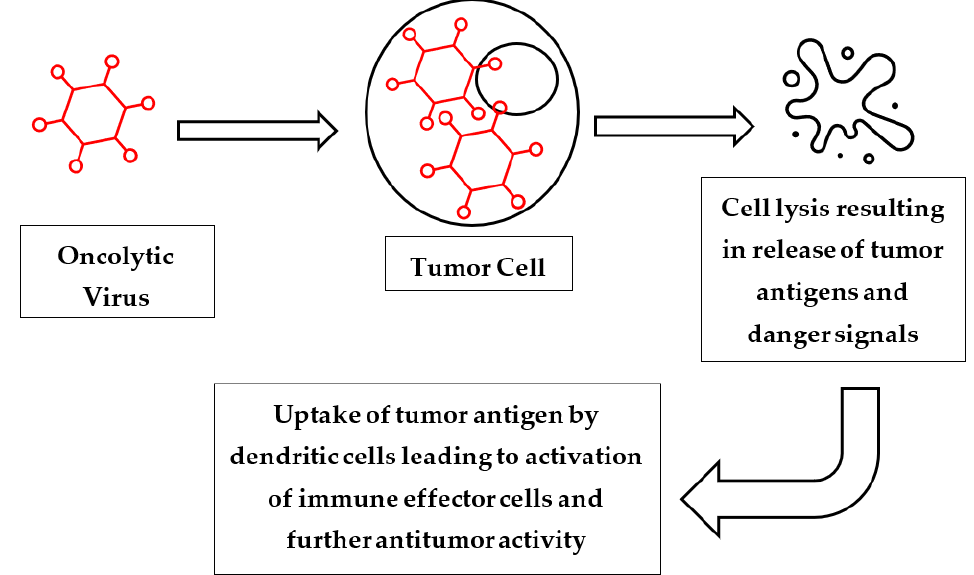
Figure 2. Mechanism of action of oncolytic viruses. Injection of oncolytic virus into tumor cell. This results in viral replication, and in turn leads to cell lysis and death. Release of tumor cell contents stimulates activation of immune effector cells via antigen presentation by dendritic cells, leading to both local and systemic antitumor effects.